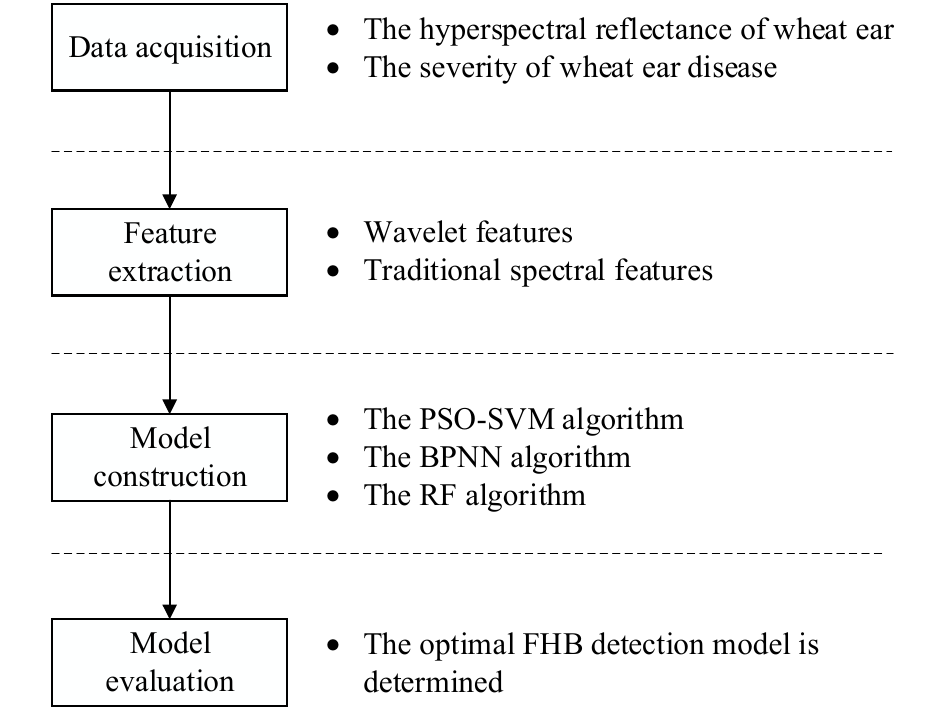
Figure 1. The workflow of the study.